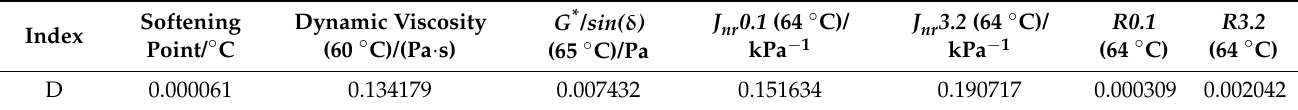
Table 4. Discrimination—calculation result of high-temperature